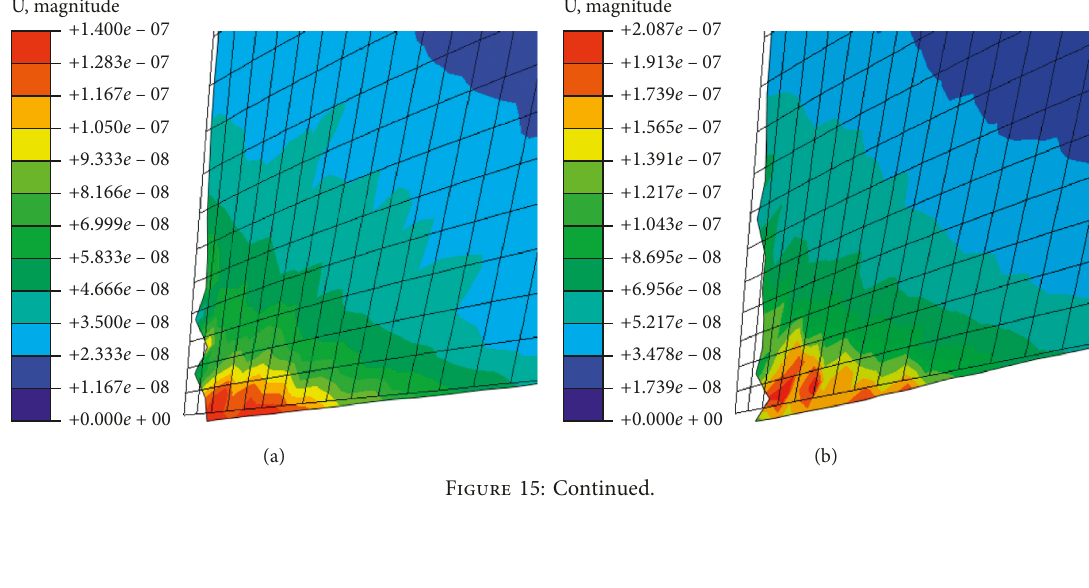
10mm and V 1.36mm/s). (cid:31) (cid:31)